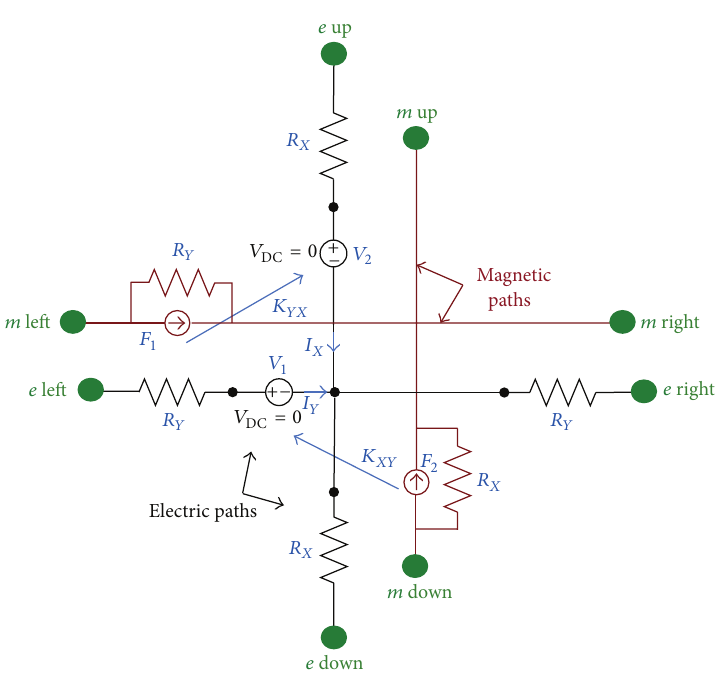
Figure 3: The elementary cell (e) model with its eight input/output pins highlighted.